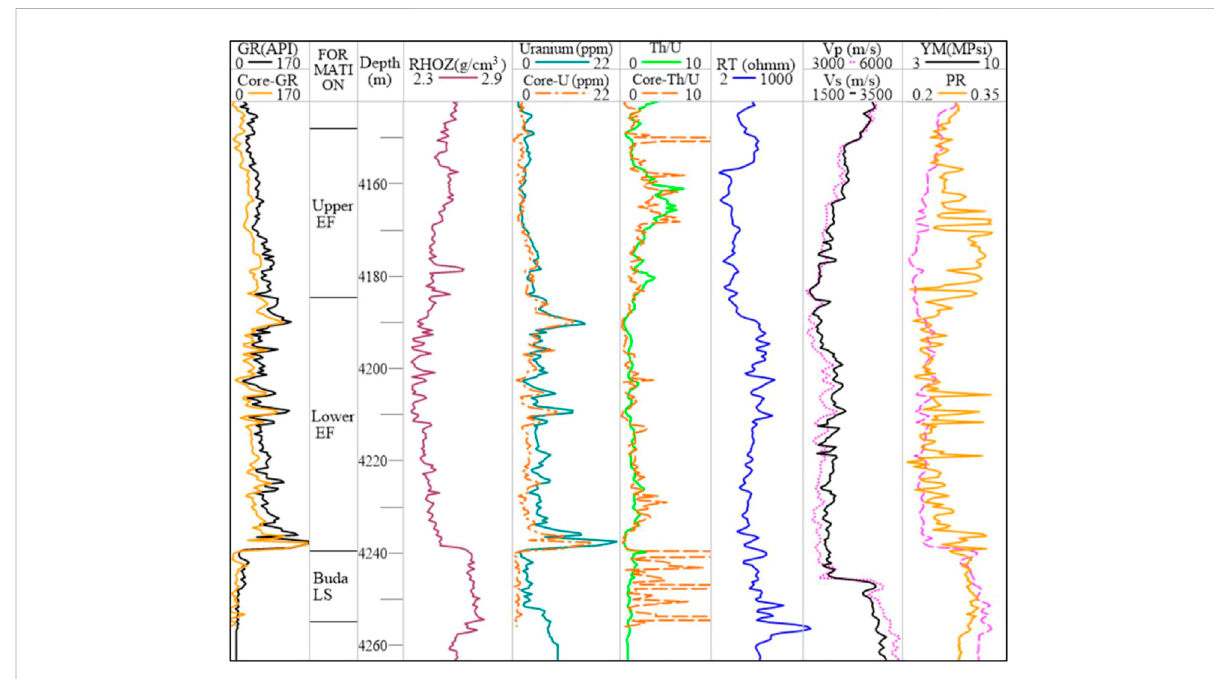
FIGURE 1 Well logs of the studied Eagle Ford well in Dewitt County,